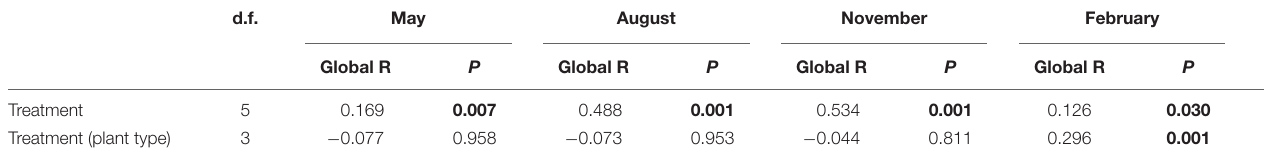
TABLE 2 | Results of two-way nested ANOSIM comparing the effects of treatment and plant type (nested in treatment) on the genus composition of periphyton.